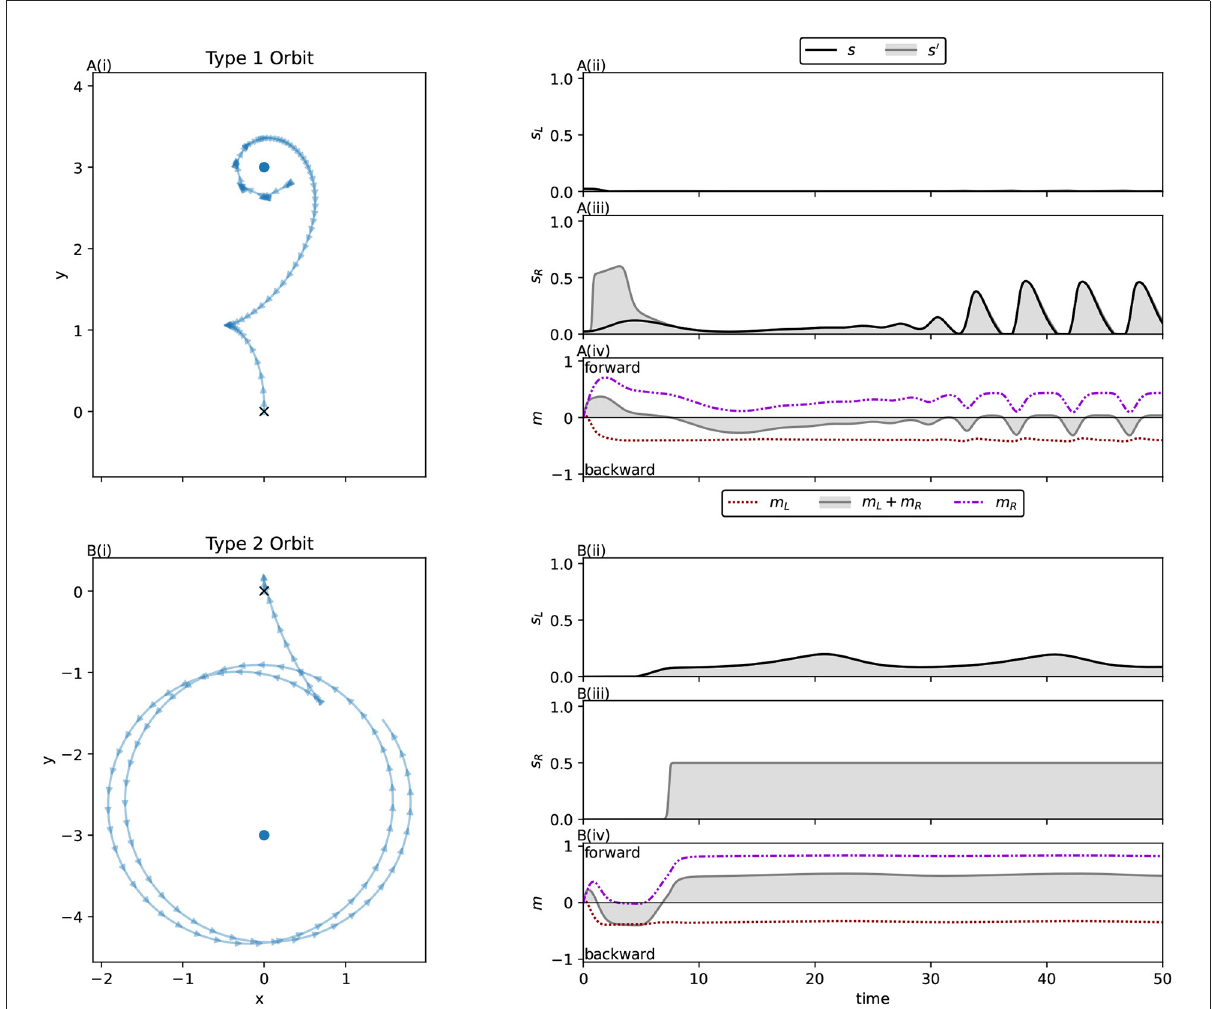
FIGURE8 Two distinct orbit types produce the bimodal right motor activity distribution seen for the solution evolved with sigmoidal interference in Figure 6B. (A) The type 1 orbit, which alternates between driving forwards and backwards to stay close to the light. (B) The type 2 orbit, where the robot exclusively drives forwards during the orbit phase. (i) The spatial trajectory of the robots, (ii,iii) the robots left and right sensor activities respectively, and (iv) the robots’ left and right motor activations. The black line in (ii,iii) shows the environmental stimulation of the sensor, while the grey line and corresponding shaded region shows the total activation of the sensor when both the environmental and motor-driven stimulation are combined. Note the minimization of interference during the Type 1 orbit, in contrast with high level of right sensor interference during the Type 2